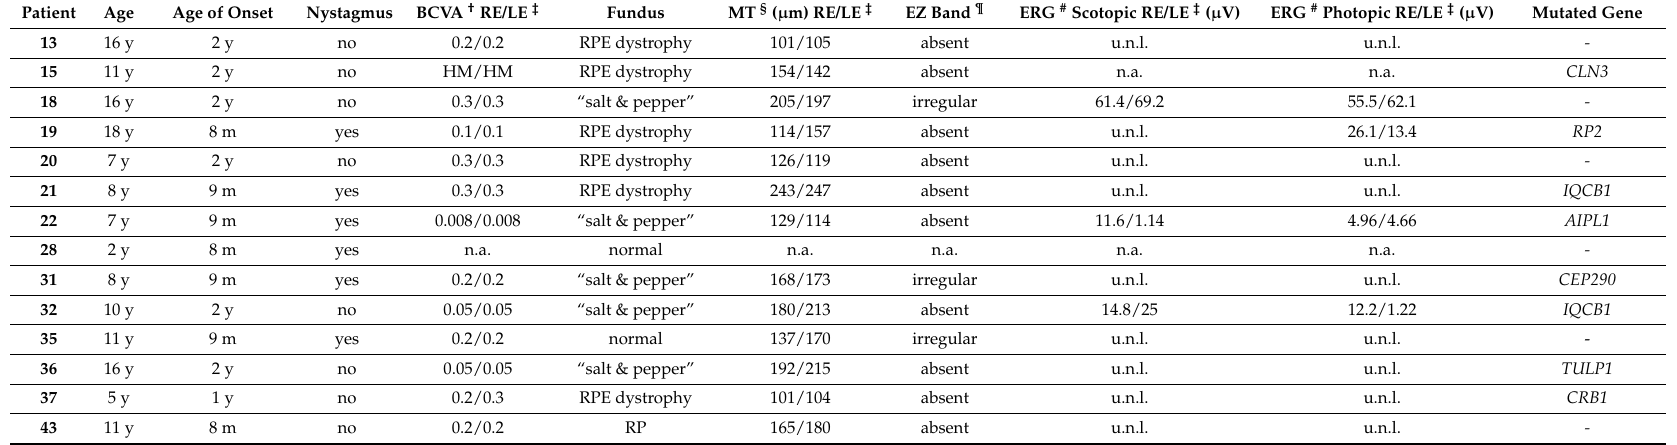
Table 3. Clinical and molecular data of Early Onset Retinitis Pigmentosa